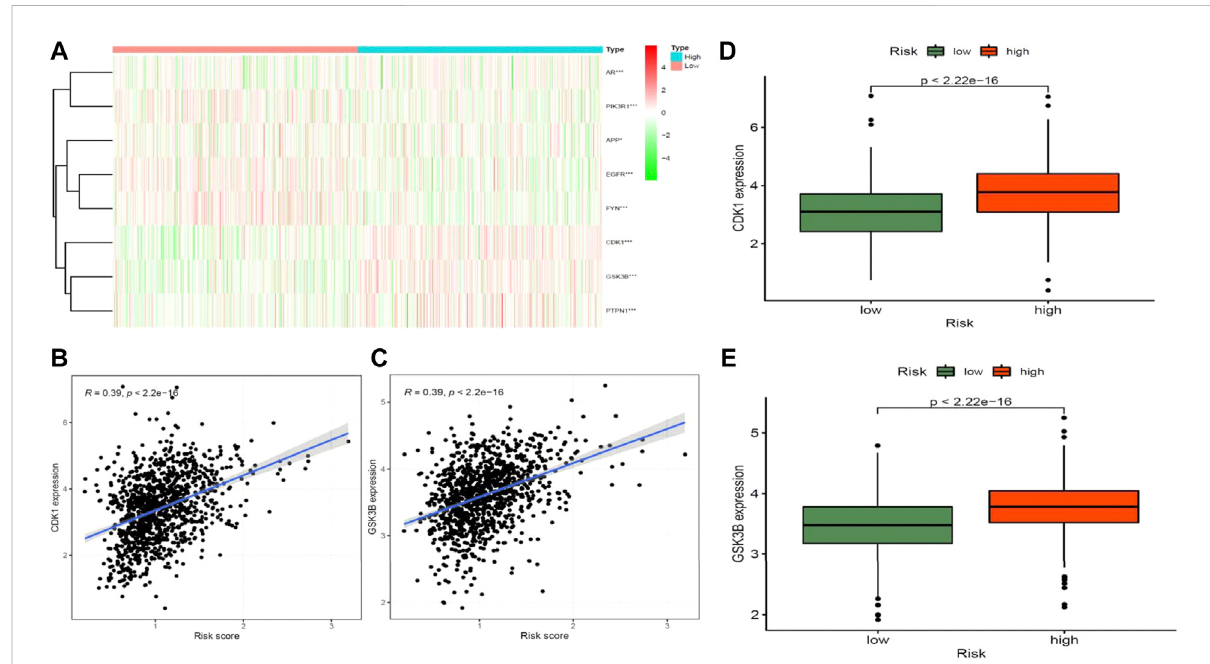
FIGURE 9 Correlation analysis between core target genes of drugs and diseases and disease risk. (A) Heat map of core genes and disease risk groupings. (B – D) CDK1 ispositively associated with disease riskscores and ishighly expressed inthe high-risk groups. (C – E) GSK3B ispositivelyassociated with disease risk scores and is highly expressed in the high-risk